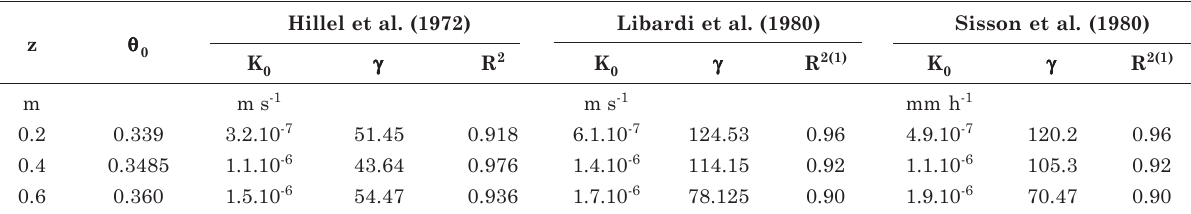
Table 4. Parameters of the K( θθθθθ ) function obtained by different methods